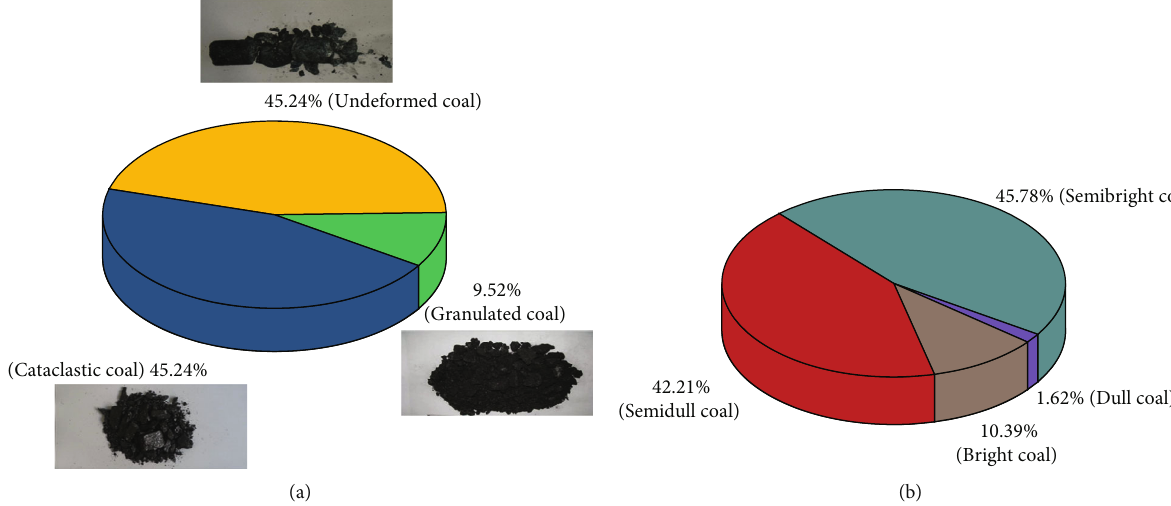
Figure 1: Distribution of coal structure and macrocoal component in the 3 # coal seam: (a) coal structure; (b) macrocoal